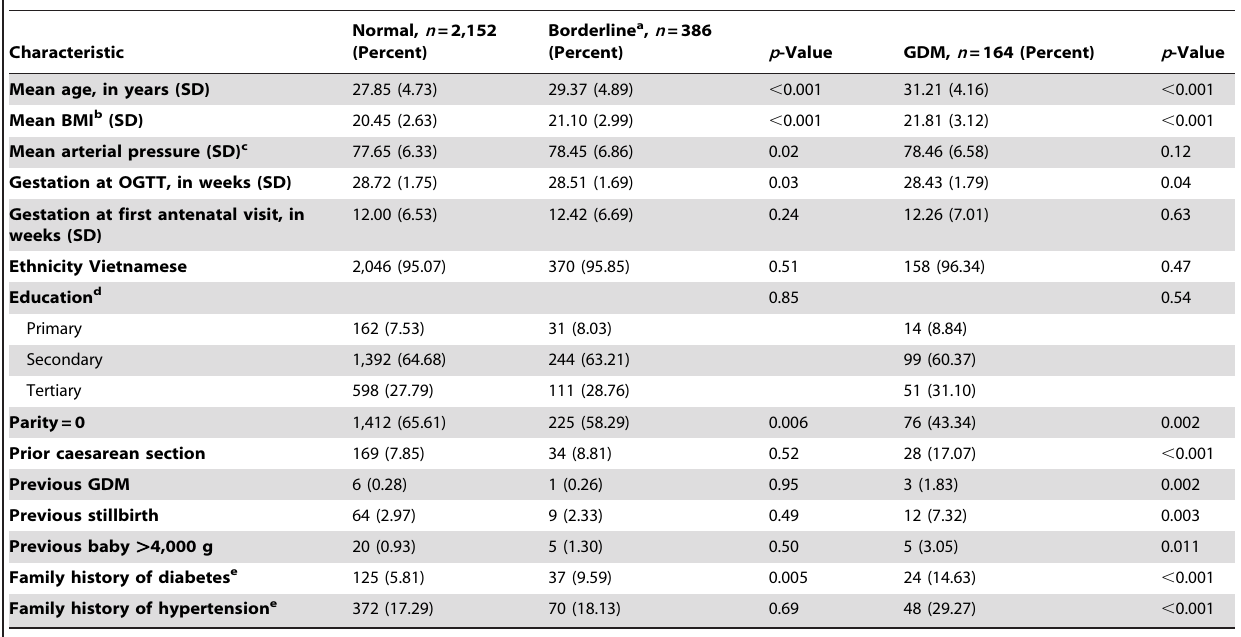
Table 1. Maternal baseline characteristics.